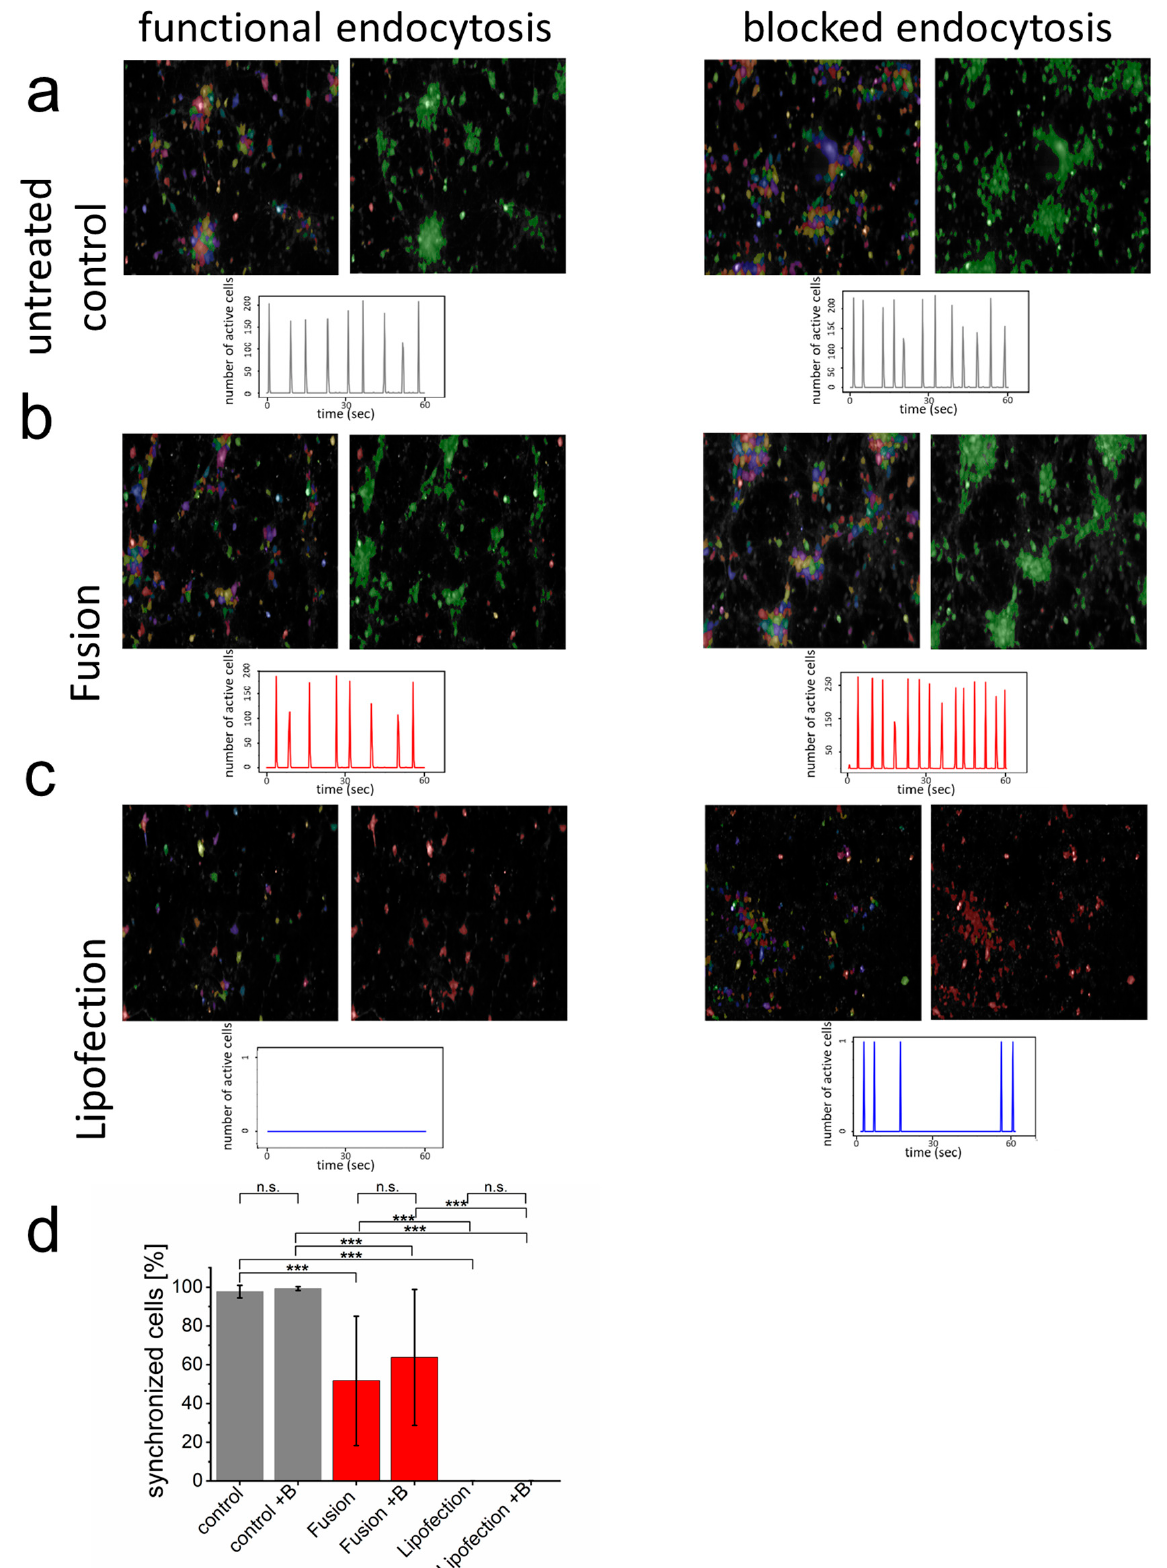
Figure 3. Endocytosis of nucleic acids impairs inter-neuronal network communication. ( a – c ) After network formation, primary cortical neurons were analyzed for functional and synchronized Ca 2+ signaling (left = all identified cells, right = synchronized cells in green and inactive cells in red) in the absence and presence of endosome inhibitor β -MCD. Inhibitor was added to the culture medium two hours before cells were transfected with GFP-mRNA by endosomal-independent (( b ), fusion) or endosomal-dependent (( c ), lipofection) transfer mechanisms and compared to the untransfected control ( a ). Statistical evaluation of all experiments including s.d. ( d ) Here, +B: addition of endoso- mal inhibitor β -MCD. eGFP-mRNA was used in a concentration of 4 µg/mL for fusion and 2 µg/mL for lipofection. In all cases, a total of 1 µg was transferred per substrate. Scale bar = 200 µm. n = three